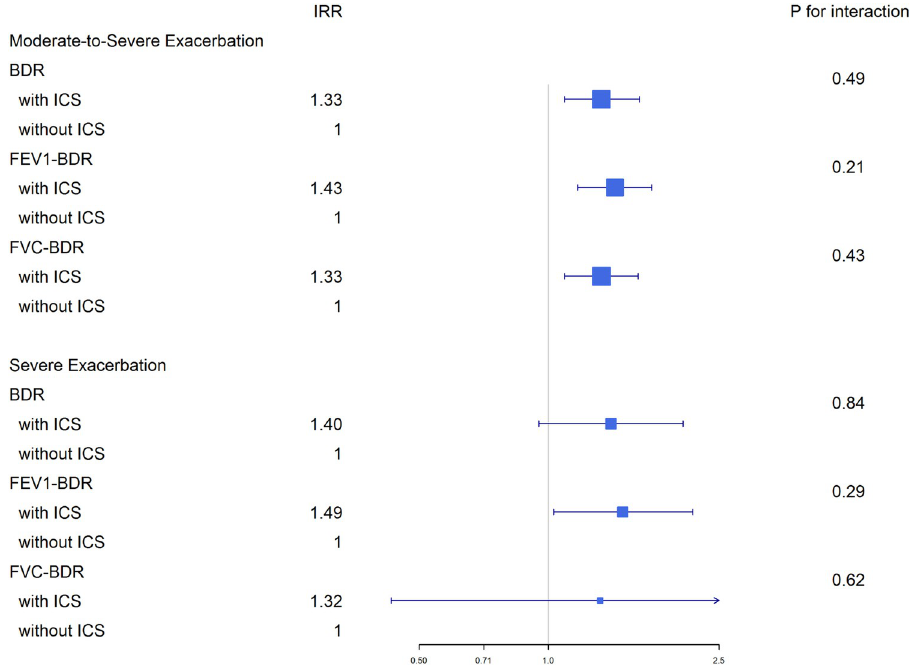
Fig 1. Interactive effects of ICS and BDR on the exacerbation